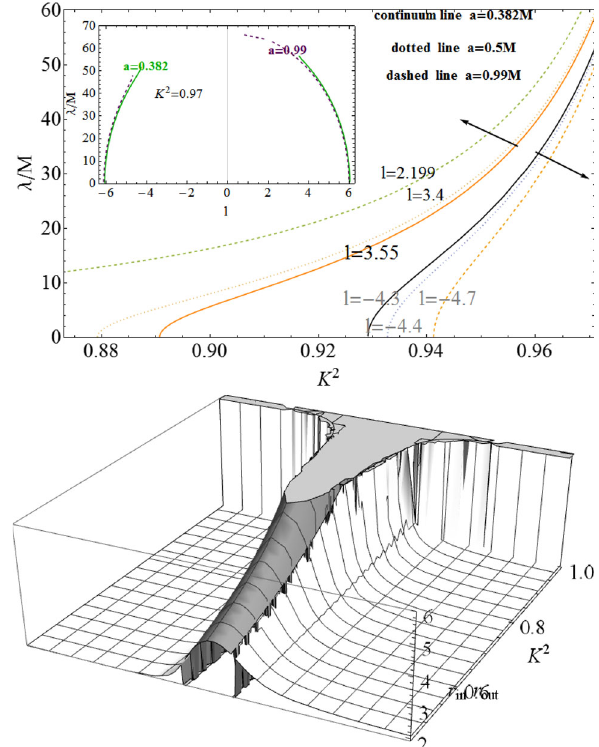
Fig. 8 Upper panel: plots of the tori elongation λ , defined in Eq. (13), for different values of the fluid specific angular momentum and SMBH spins as function of the K 2 where K ∈] K ± mso , 1 [ parameter for counter- rotating and corotating tori respectively. Arrows indicate the increasing BH spin a / M for the corotating and the counterrotating curves. Inside panel , tori elongation λ at fixed K 2 , for different SMBH spins, as func- tion of fluid specific angular momentum (cid:4) . It is clear the symmetry of between the (cid:4) corotating and (cid:4) counterrotating configurations. Bot- tom panel , torus inner edge r in (white) and outer edge r out (gray) in Eq. (14) as functions of K 2 and fluid specific angular momentum, for SMBH spin a / M = 0 .